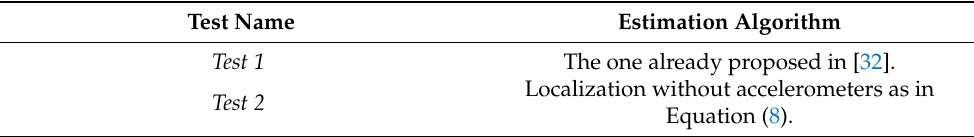
Table 1. Experimental tests for the localization without speed